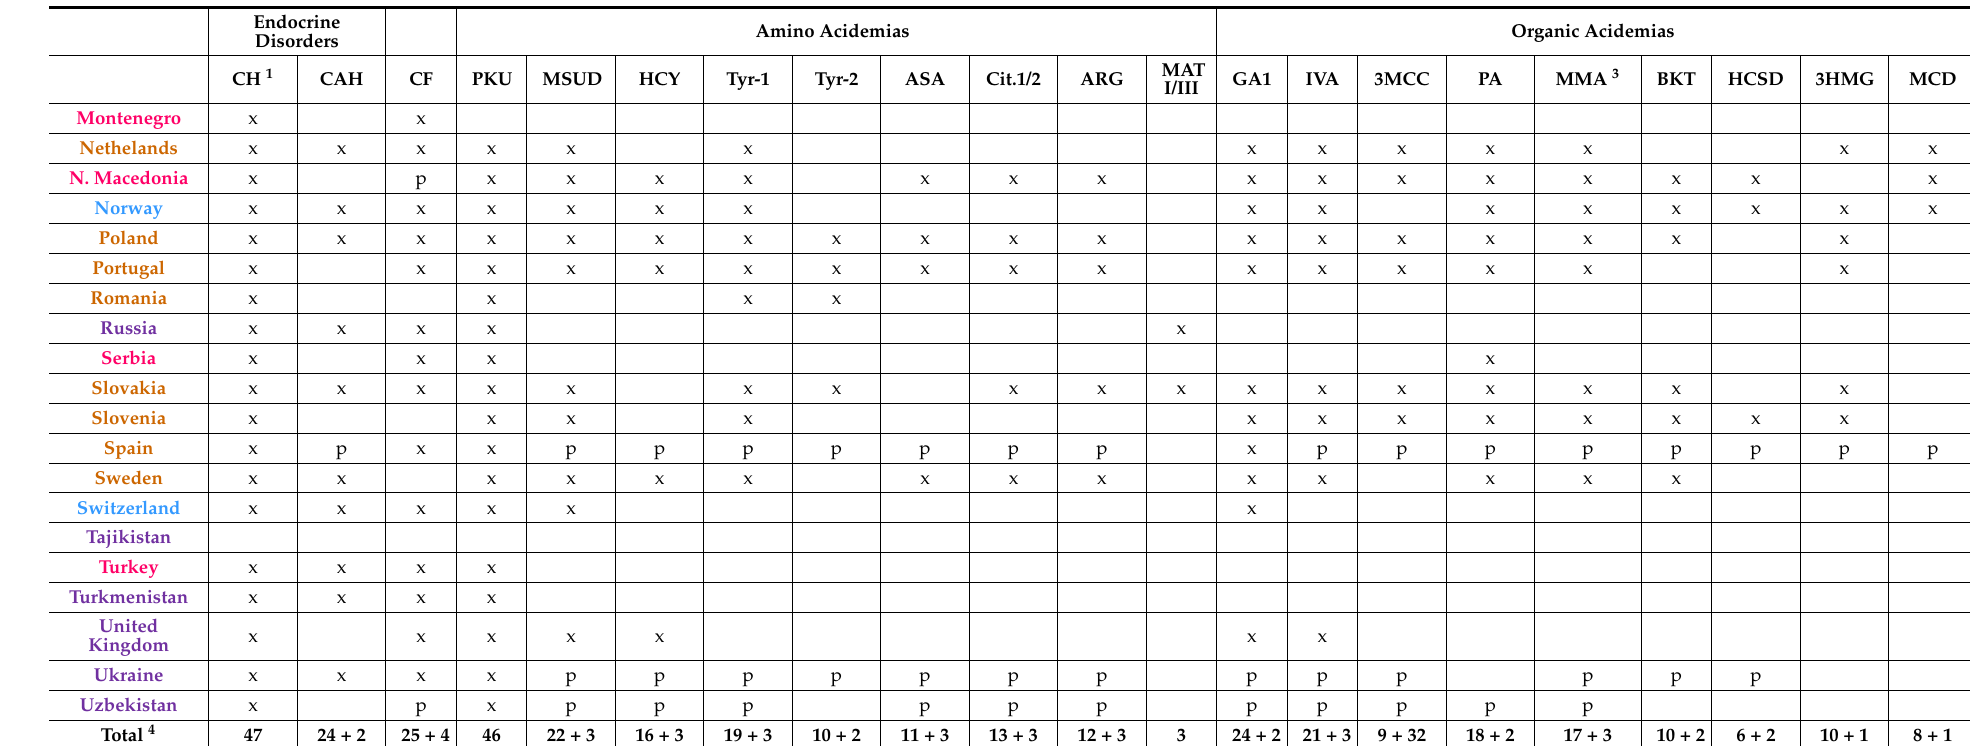
Colour indications countries: EU member (brown), candidate EU member (fuchsia), potential candidate EU member (green), EFTA member (blue), Europe-other (purple). 1 for explanation of abbreviations, see the list in the main text; 2 x = in screening panel; p = pilot/regional screening; 3 total number of conditions in screening panel; total number of pilots; 4 MMA includes MMAmut, Cbl deficiencies and Vitamin B12-deficiency;